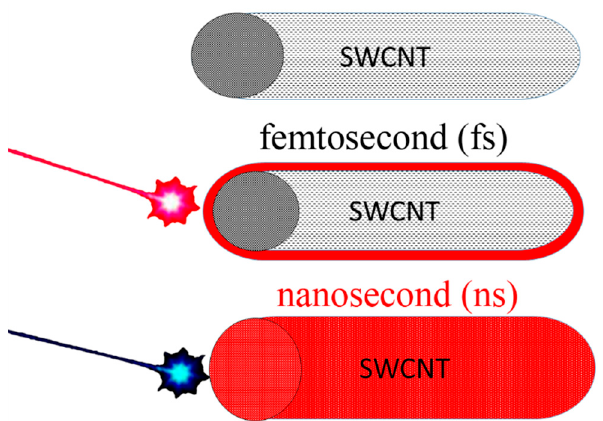
Figure 5. Thermal e ff ects of femtosecond and nanosecond laser pulses on single wall carbon nanotube Figure 5. Thermal effects of femtosecond and nanosecond laser pulses on single wall carbon nanotube (SWCNT).